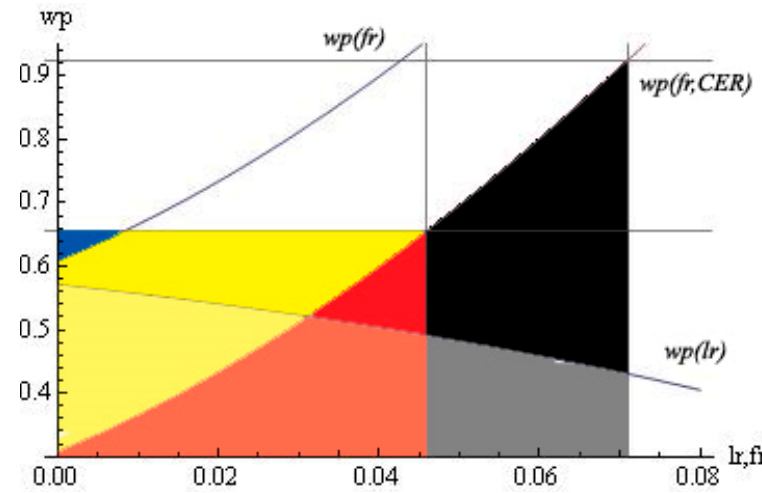
Figure 4. Characterization of a financially infeasible irrigation project. Financial feasibility and social sustainability account for 0% of the reliable economic solutions. Black, unreliable solutions, infeasible for farmers and for the government; grey, unreliable solutions, feasible for farmers but not for the government; red, infeasible for farmers and the government; yellow, infeasible for farmers but feasible for the government if it sells CER credits; blue, infeasible for farmers but feasible for the government without selling CER credits; light red, feasible for farmers but not for the government; light yellow, feasible for farmers and feasible for the government if it sells CER credits.